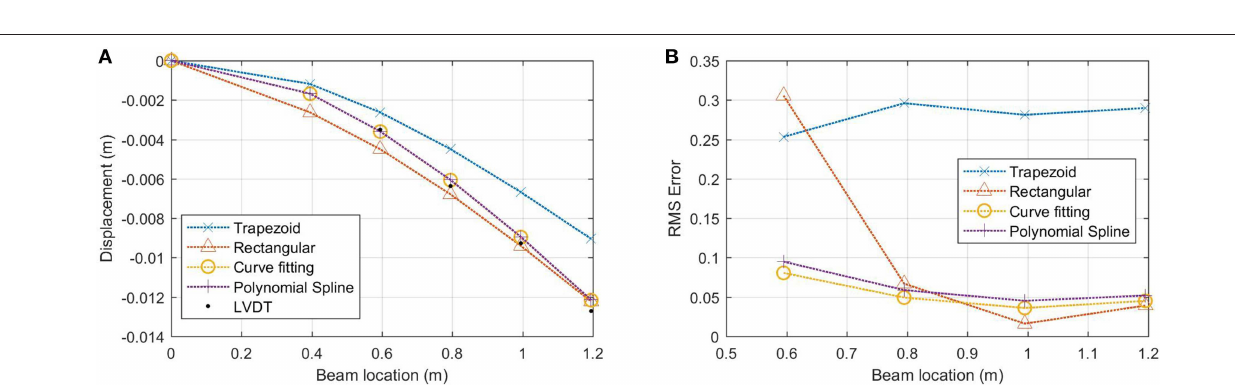
method had the lowest Pearson coefficient whereas the SMT method had the lowest errors and highest Pearson